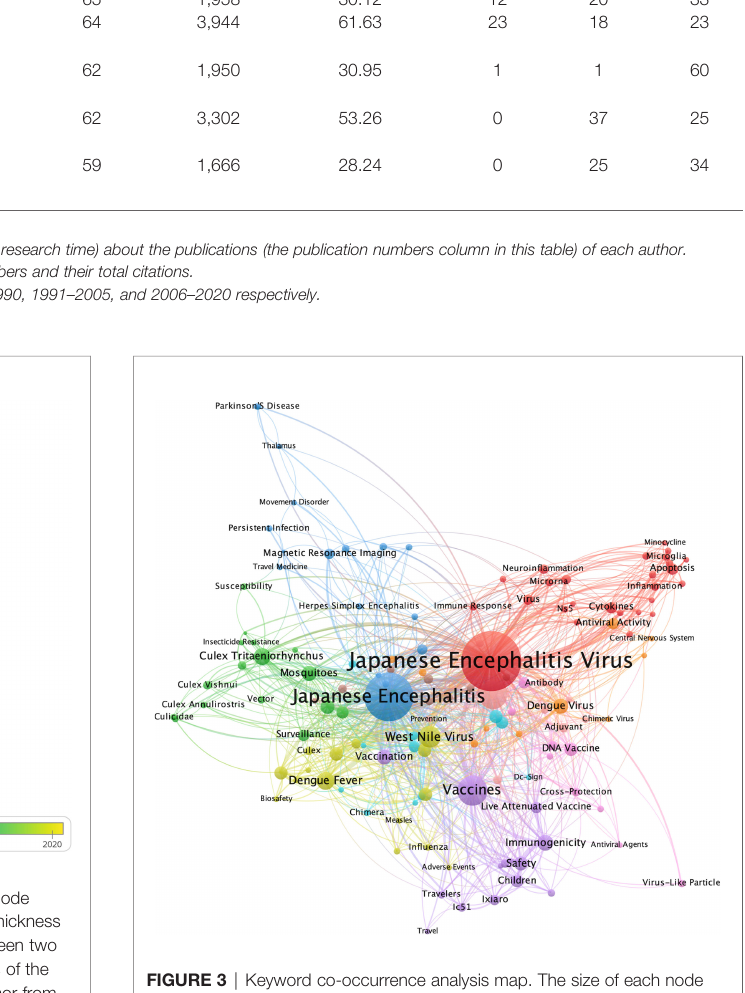
FIGURE 3 | Keyword co-occurrence analysis map. The size of each node indicates the occurrence of the keyword in all 3,023 publications. The thickness of each link indicates the strength of co-occurrence relationship between two keywords. The distance between two nodes indicates the relatedness of the links they each has. Nodes with common attributes are assigned to a color-coded